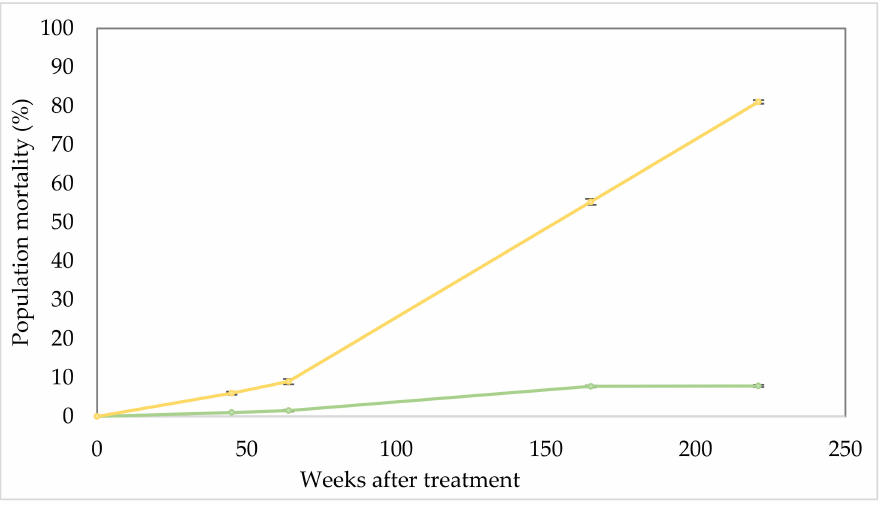
Figure 3. North parkinsonia infestation mortality over trial duration (0, 45, 64, 165 and 221 WAT). Treated plants (gold), untreated control plants (green). Error bars represent ± standard error of